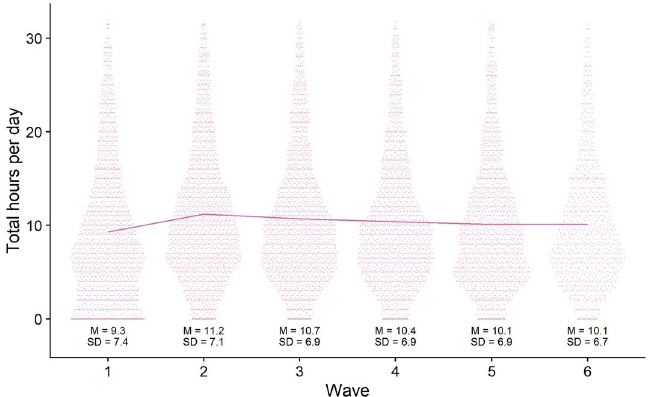
Figure 5. The figure displays the summed media use of all media plus means and standard deviations. The line connects the means between waves.